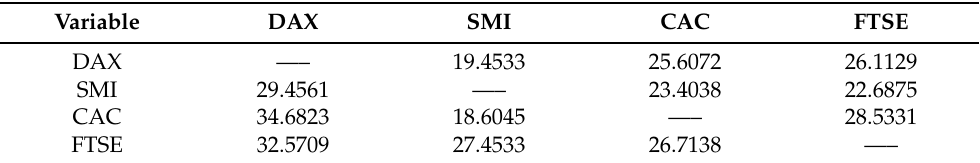
Table A2. TCE risk measures for θ = 0.95 and t = 0.95 with bivariate Gaussian copula left panel (with ρ = 0.9) and right panel (with ρ = 0.95).